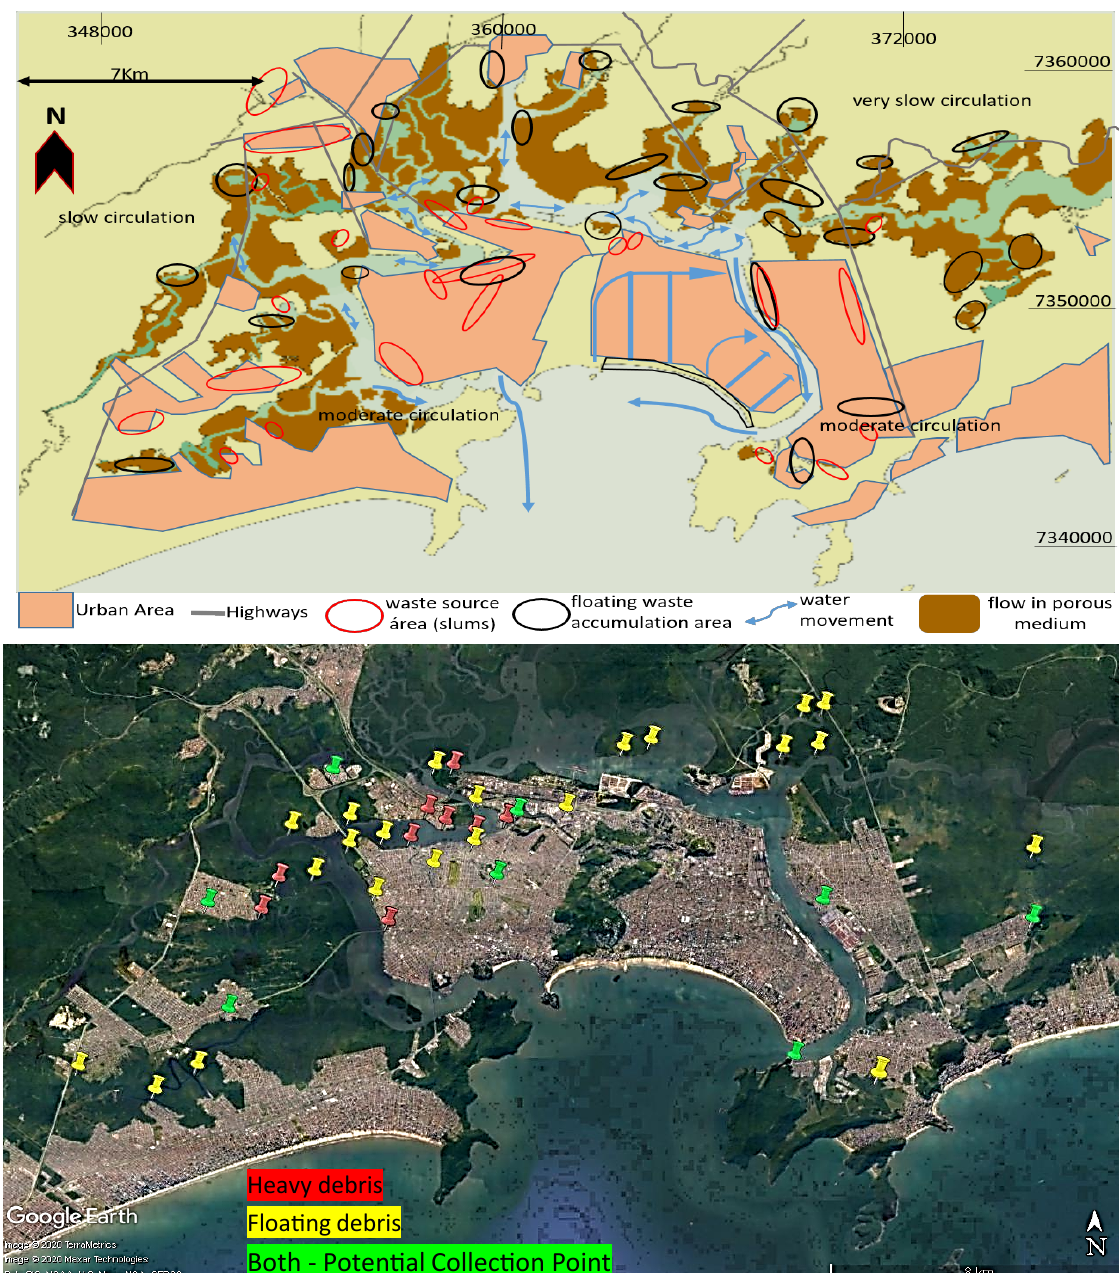
Fig. 4. Above: Water circulation and possible debris areas (based on Roversi et al. 2016b). Below: Debris accumulation points, verified by Google Earth